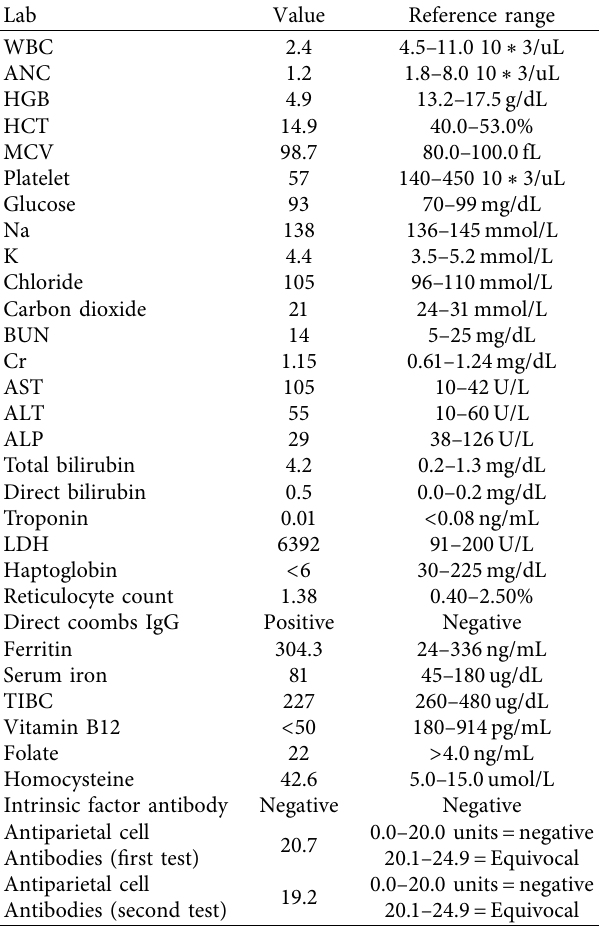
Table 1: Laboratory